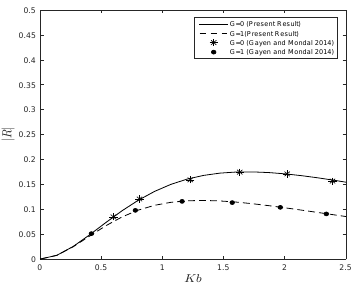
Figure 2. | R | vs. dimensionless wavenumber Kb with µ = 0 . 25 and G = 0 , 1 .